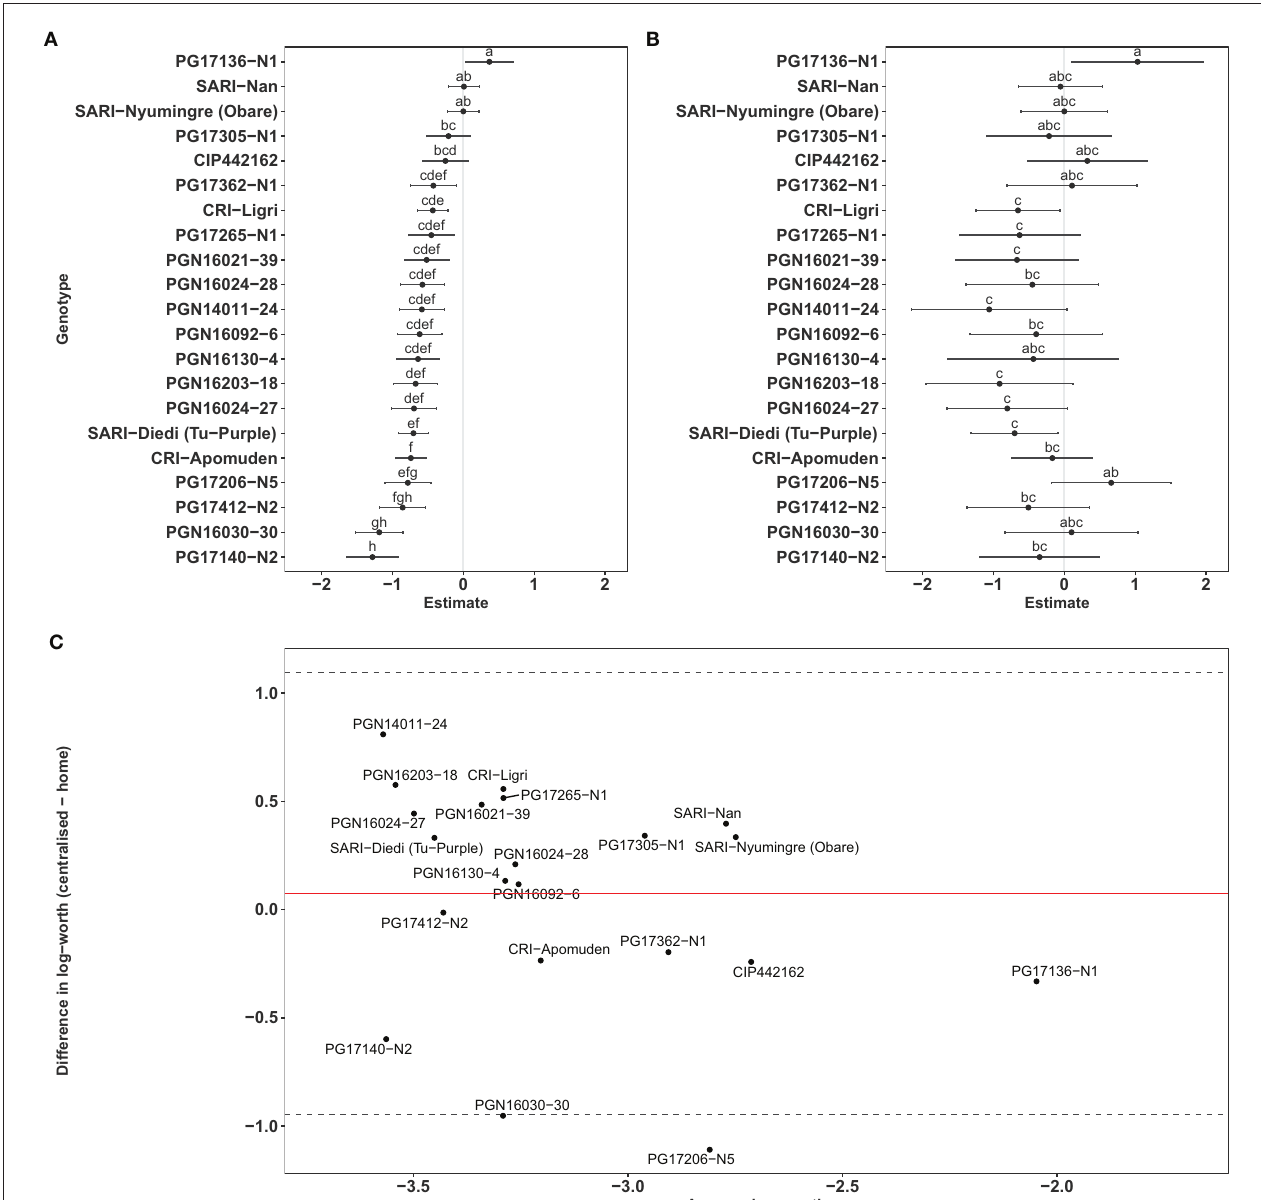
FIGURE 4 | Plackett-Luce Model estimates (log-worth parameters) from tested genotypes in Ghana. Different letters indicate significant differences at p < 0.05. (A) Log-worth parameters from centralized tasting. (B) Log-worth parameters from home tasting. (C) Differences between log-worth parameters in centralized and home tasting in Ghana. The genotype “SARI-Nyumingre (Obare)” is set as a reference (log-worth arbitrarily set to zero). In (C) , solid red line represents the mean of difference in log-worth (centralized–home), upper dashed lines represent the mean + 2SD (standard deviation), bottom dashed line represent the mean − 2SD.